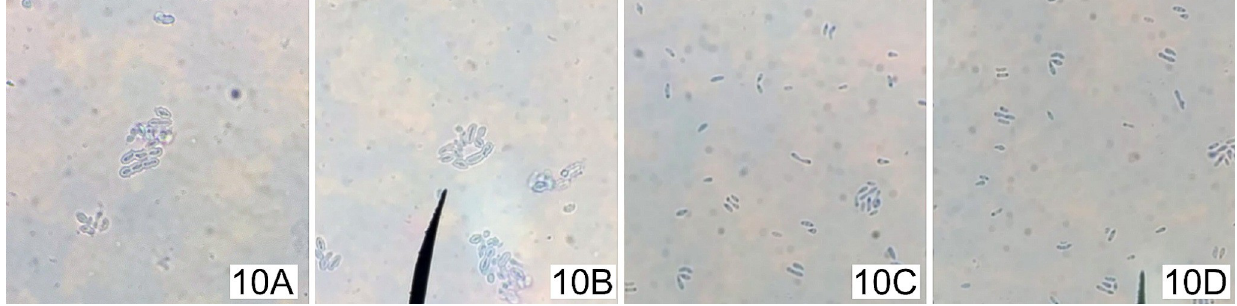
Fig 10. Representative images of serotyping using the quellung test with soluble 47B3 VH. Preparations of S . suis serotype 2 incubated with the commercial anti- S . suis serotype 2 pAb (A), S . suis serotype 2 incubated with soluble 47B3 VH (B), S . suis serotype 1/2 incubated with soluble 47B3 VH (C), and S . suis serotype 2 without antibody (D) were viewed under 1000X light